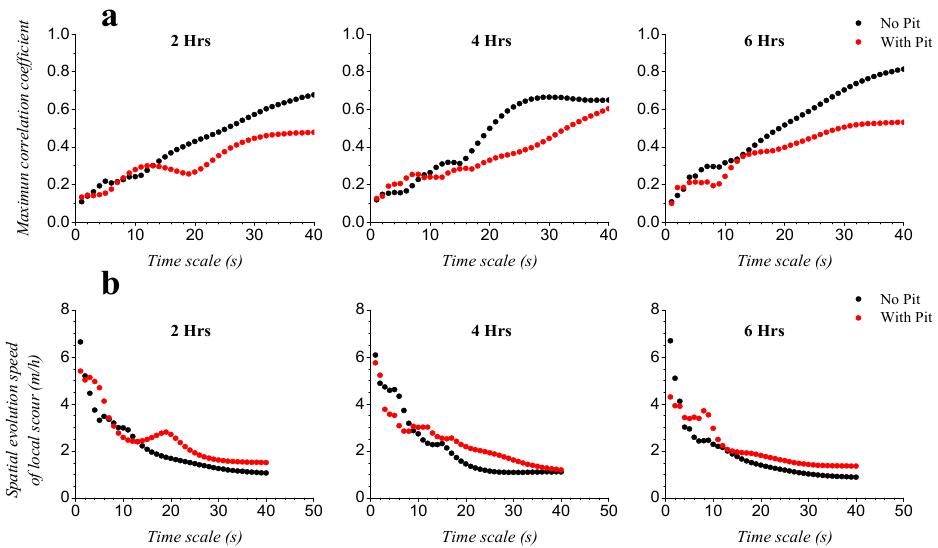
Figure 12. ( a ) Maximum correlation coefficients between the wavelet-coefficients upstream and downstream of the pier front and ( b ) spatial evolution speed of local scour at various time scales for both cases.